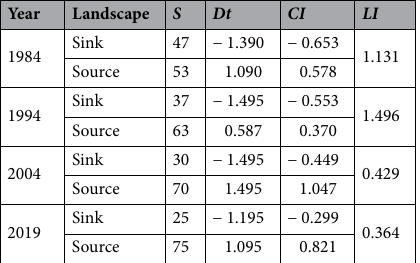
Table 5. Variations in LST of the source and sink with their landscape index over Lagos.